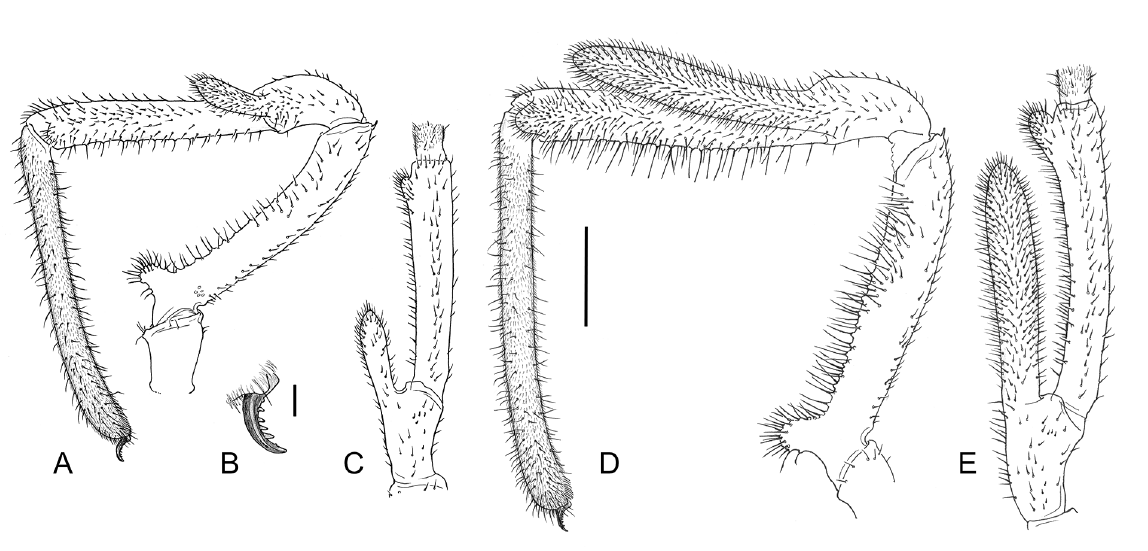
Fig. 11. Dicranopalpus cantabricus Dresco, 1953 (ZUPV 4542). Right pedipalp. A – C . Male. D – E . Female. A , D . Median view. B . Claw. C , E . Dorsal view of patella and tibia. Scale bars: A, C–E = 0.5 mm; B =